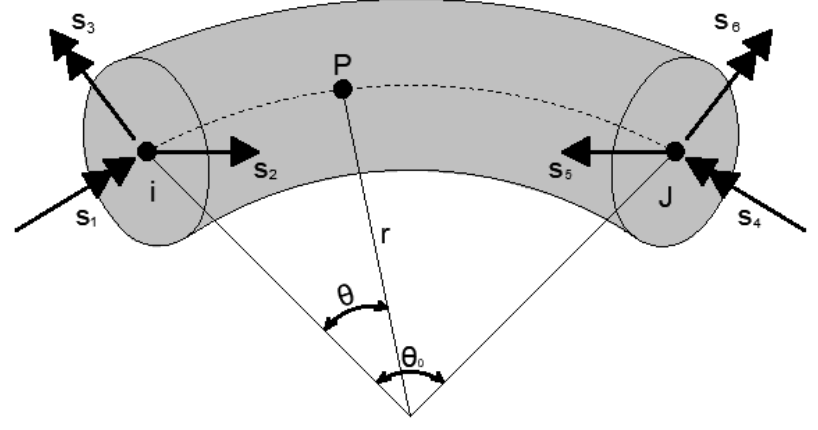
Figure 6. Curved grid finite